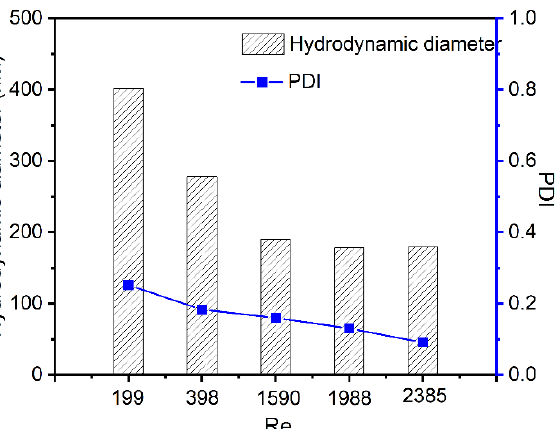
Figure 7. Effect of Re on the average particle size and polydispersity index (PDI) of Cur-loaded CS nanocomplex.